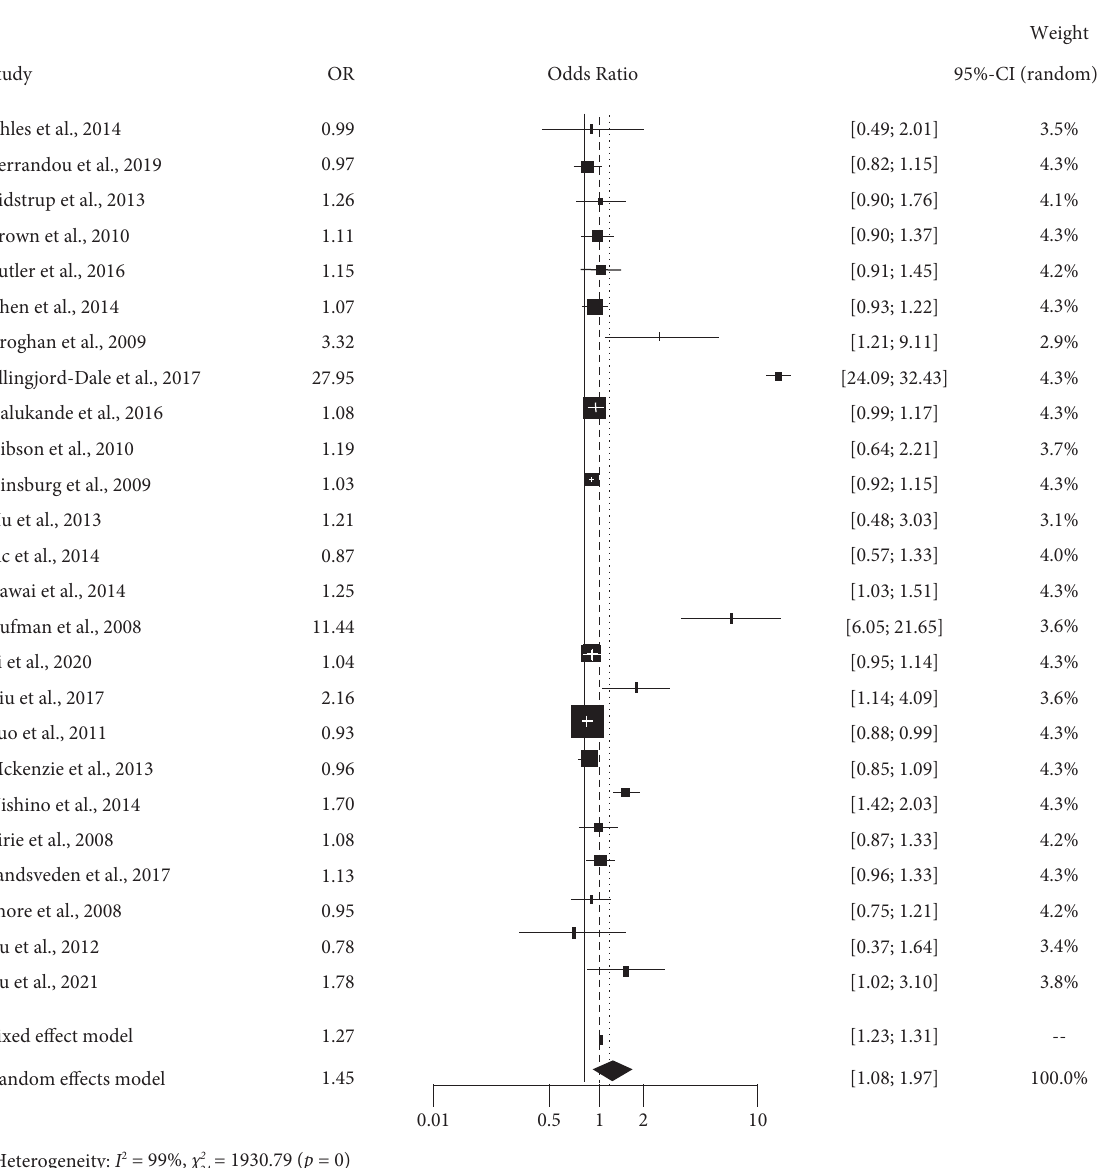
Figure 2: Forest plot showing the smoking infuence on breast